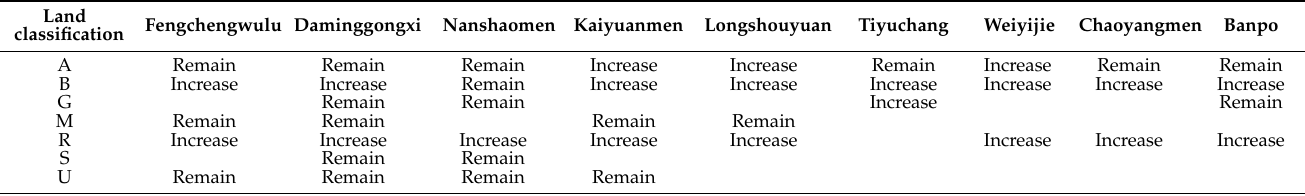
Table 4. Areas with low development intensity and optimization plans for the development intensity at each station.